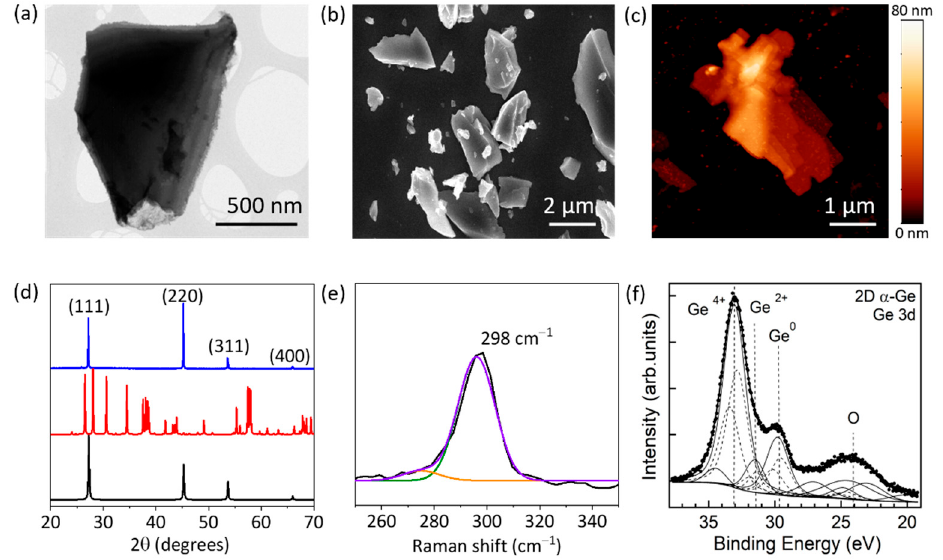
Figure 1. ( a ) TEM image of a typical 2D α -Ge. ( b ) General SEM image of characteristic 2D α -Ge. ( c ) AFM image of a typical 2D α -Ge. ( d ) XRPD patterns of 2D α -Ge (blue line), simulated hexagonal crystalline GeO 2 (red line), and simulated crystalline Ge (black line). ( e ) Raman spectrum of 2D α -Ge before the cycling process. Raman spectrum measurement (black line), deconvoluted contributions of crystalline α -Ge at 298 cm − 1 (green line), amorphous Ge at 275 cm − 1 (orange line), and cumulative plot of both contributions (purple), laser power of 1.75 mW. ( f ) Ge 3d and O 2s XPS peaks (h ν = 1253.6 eV) for 2D α -Ge before cycling. Experimental data (dotted line) and resulting fit (thick continuous lines). Thin lines correspond to the different contributions, and dashed lines to the spin-orbit splitting of Ge 3d.